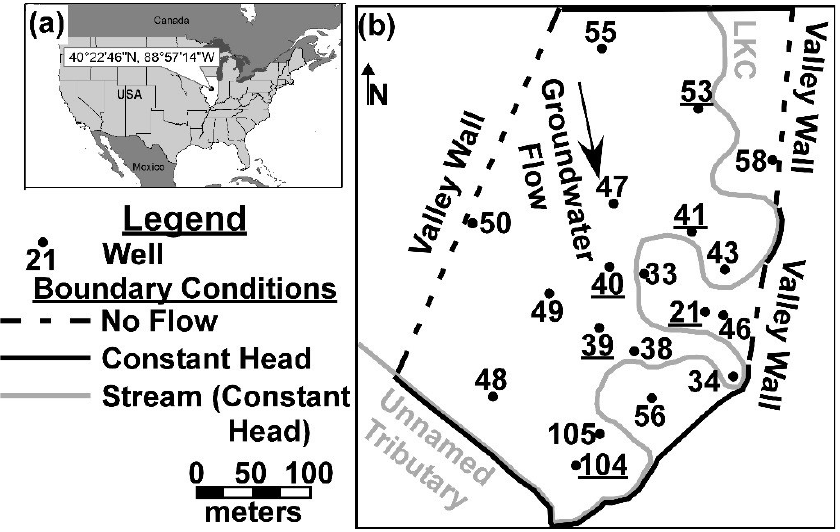
Figure 1. ( a ) Model area of Little Kickapoo Creek (LKC) in central Illinois, USA (40°22′46″ N, 85°57′14″ W) ( b ) Model domain with boundary conditions (black lines), streams (grey), and wells (circles). Groundwater flows to the south-southeast.